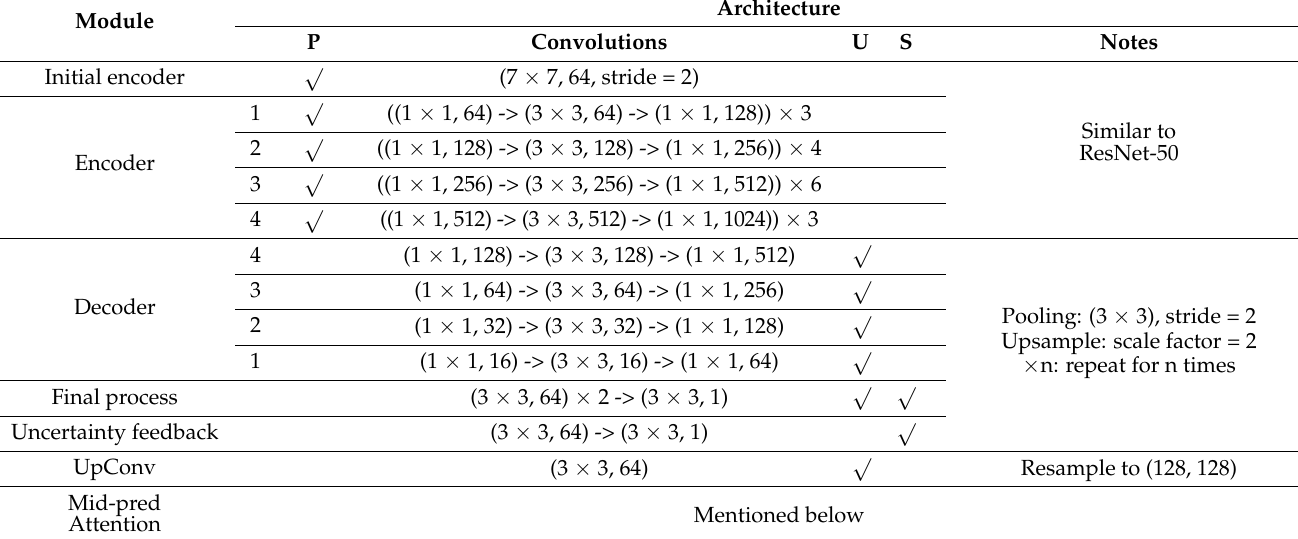
Table 1. Detailed parameters of each module within the network. P: pooling; U: upsample; S: